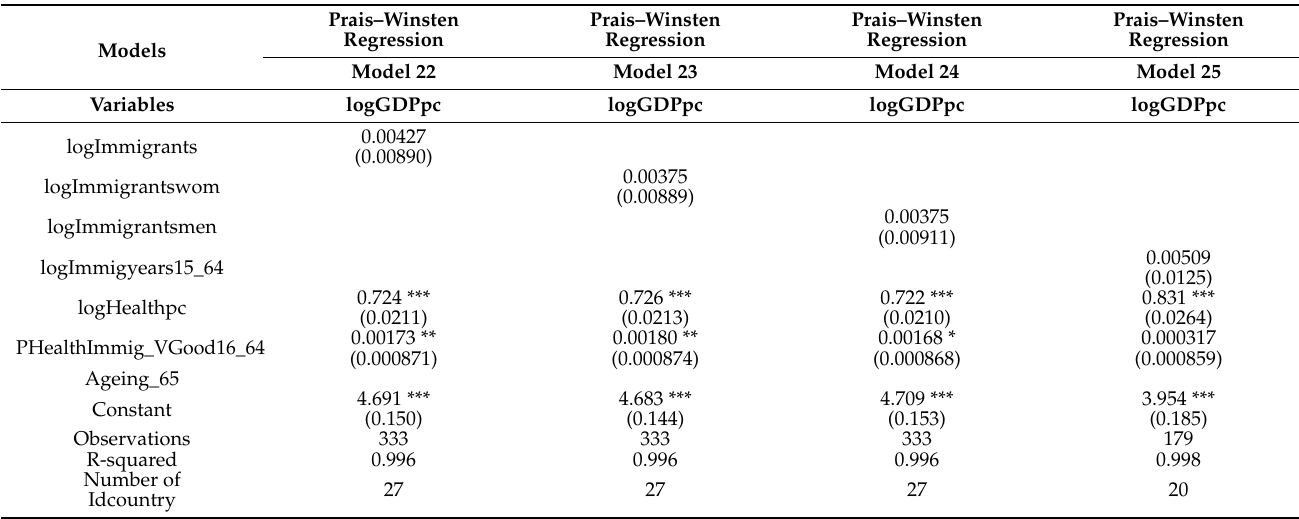
Table 6. Prais–Winsten Regression models with different variables representing immigration without Ageing_65